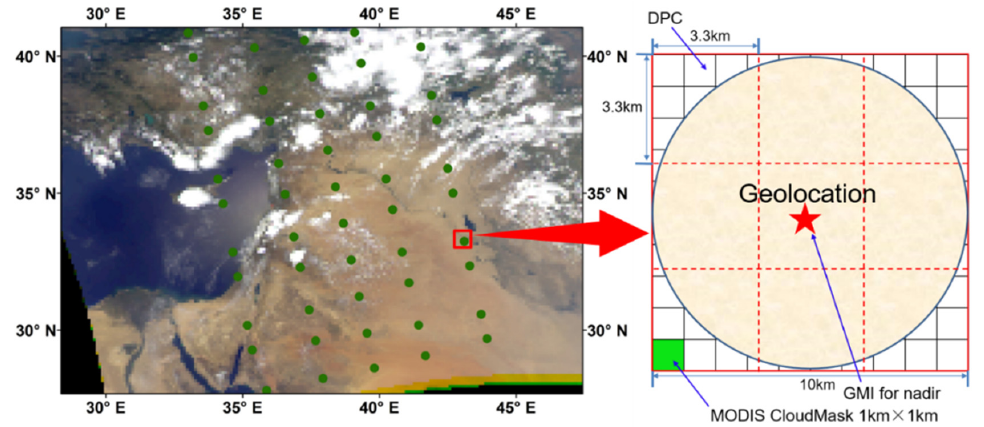
Figure 15. Schematic diagram of GMI, DPC and MODIS data space matching.